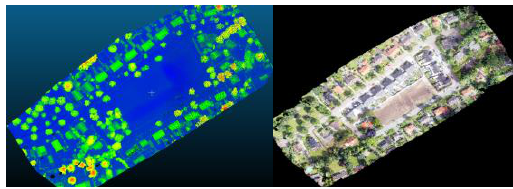
Figure 2. Left; ALS data; Right: UAV Orthomosaic image